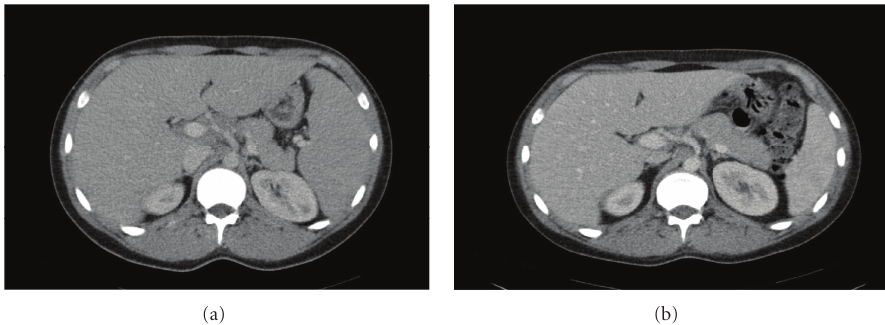
Figure 1: CT scan of the abdomen before (a) and after (b) first line of